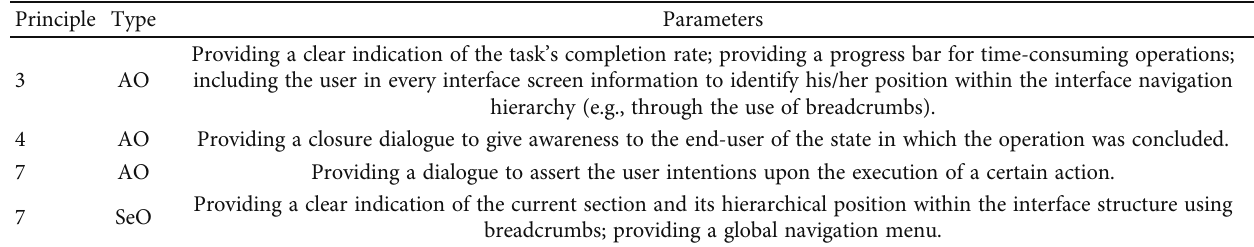
Table 5: Shneiderman ’ s golden rules of parametrization [152 –